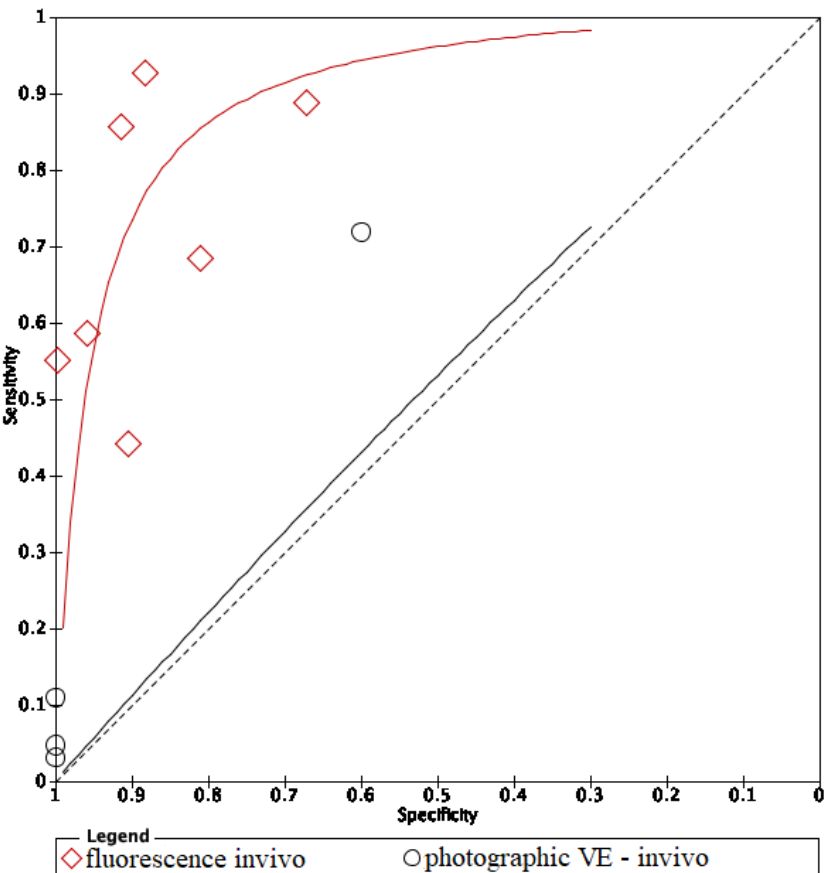
Figure 12. In vitro comparison of visual inspection and photographic visual examination. The ROC curve of in vivo fluorescence is directed towards the upper left corner than the curve of in vivo visual photographic examination (Figure 13).